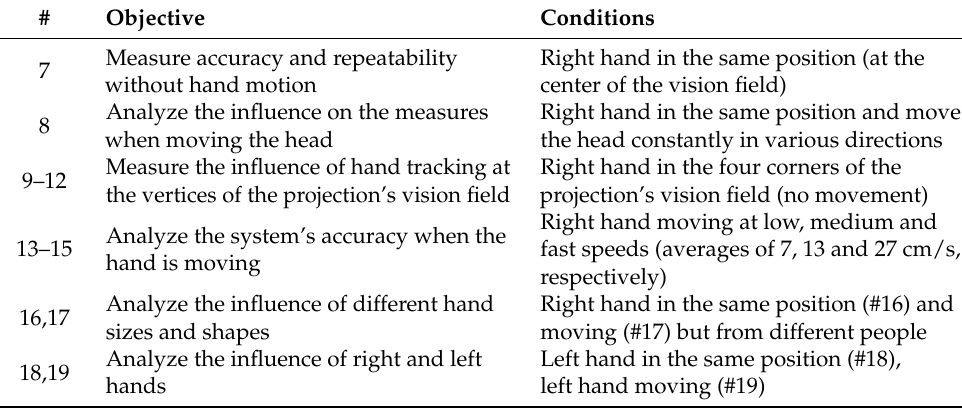
Table 2. HoloLens 2